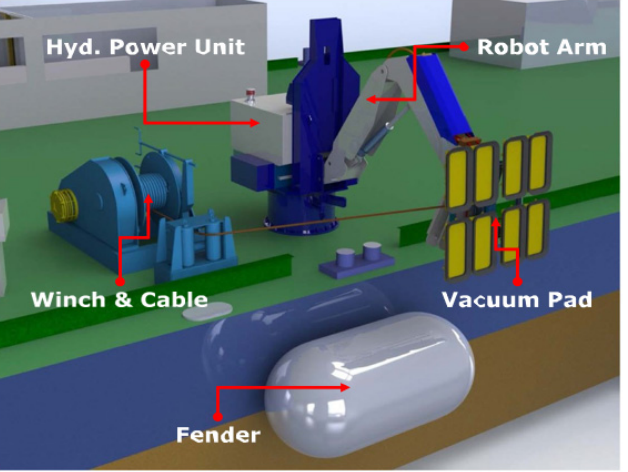
Figure 4. Hardware and arrangement of the automated mooring system (adapted with permission from Ref. [27]. 2014. YongYook, Kim).